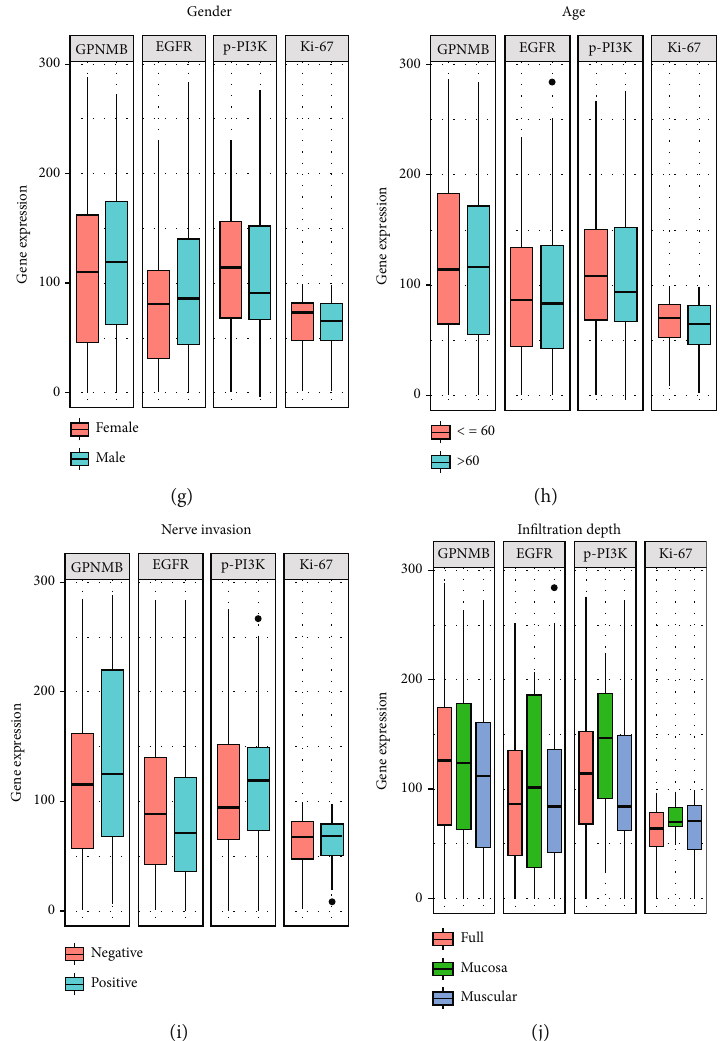
Figure 5: Expression of GPNMB, EGFR, p-PI3K, and Ki-67 in di ff erent clinicopathological strati fi cations. The expression di ff erence of the 4 proteins between (a) di ff erent lymph node metastasis states, (b) di ff erent di ff erentiation levels, (c) di ff erent nationalities, (d) di ff erent ESCC locations, (e) vascular invasion or not, (f) di ff erent tumour sizes, (g) di ff erent genders, (h) di ff erent age groups, (i) nerve invasion or not, and (j) di ff erent in fi ltration depths. The Wilcoxon rank-sum test was used for the comparison between two samples, and the Kruskal-Wallis rank-sum test was used for the comparison between multiple samples. Adjusted P values are shown as follows: ns: not signi fi cant, ∗ P < 0 : 05 , ∗∗ P < 0 : 01 , and ∗∗∗ P < 0 : 001